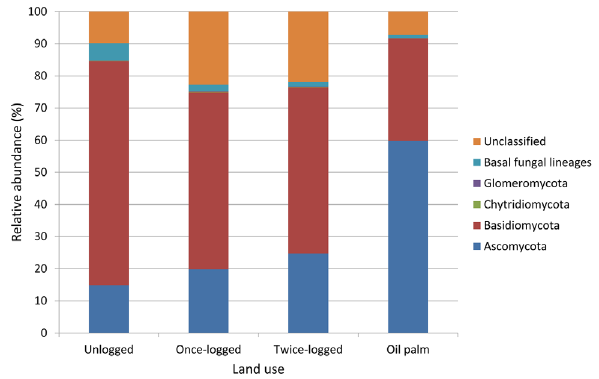
Figure 3. Relative abundance of dominant fungal phyla among different land uses in Sabah, Malaysian Borneo.